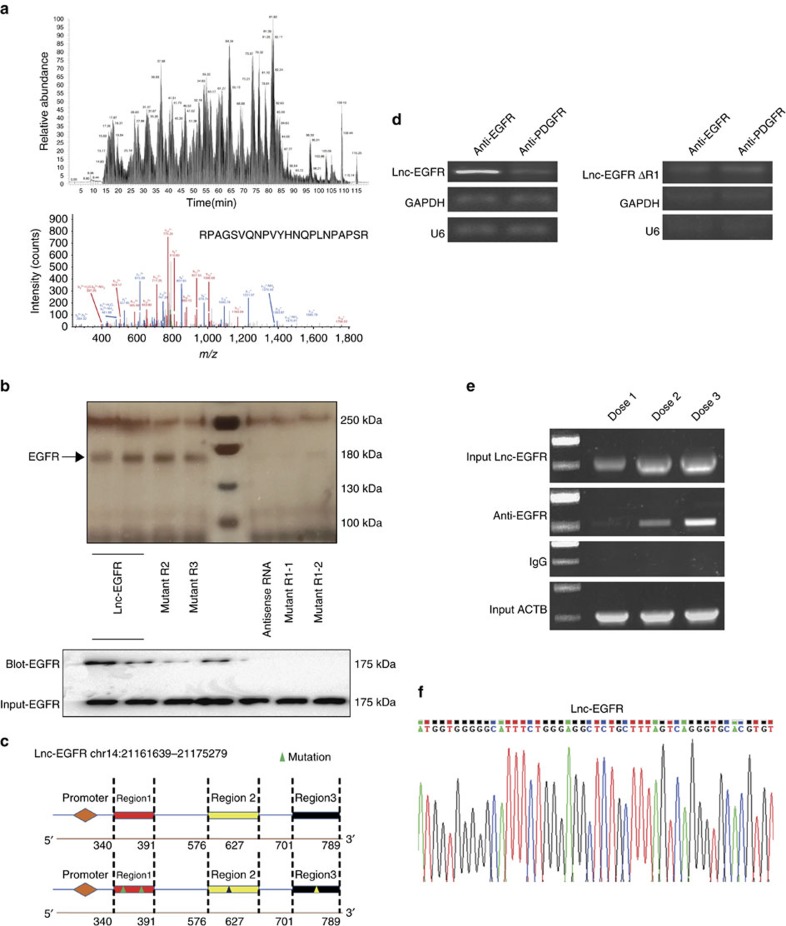
Cytoplasmic lnc-EGFR binds specifically to EGFR.(a) Lnc-EGFR RNA pull-down assay was performed. The associated proteins were processed and subjected to Mass Spec. followed by analysis via the Proteome Discoverer program (a1) and the NCBI protein database with the Mascot search engine (a2). (b) RNA pull-down assay was performed (b1) and the associated proteins were detected with anti-EGFR antibody (b2). A schematic map of potential EGFR binding regions (R1 to 3) in lnc-EGFR (b3). Triangles indicate deletion mutations. (c) Lnc-EGFR specifically interacts with EGFR. c1: RIP assays were performed using CD4+ T cells transduced with either lnc-EGFR or lnc-EGFRΔR1 lentiviral particles, and anti-EGFR or anti-PDGFR antibodies. The precipitated RNAs were determined by qPCR for lnc-EGFR, lnc-EGFRΔR1, GAPDH or U6. c2: CD4+ T cells were transduced with different doses of lnc-EGFR lentiviral particles and the association of lnc-EGFR with EGFR was determined by RIP assay using anti-EGFR antibodies and qPCR for lnc-EGFR. c3: The amplified sequence (Lnc-EGFR range from 337 to 379 bp) was validated by Sanger sequencing. Each experiment was performed triplicated.